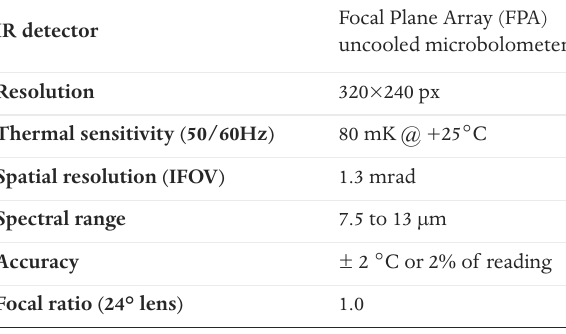
Table 1. FLIR A40 technical